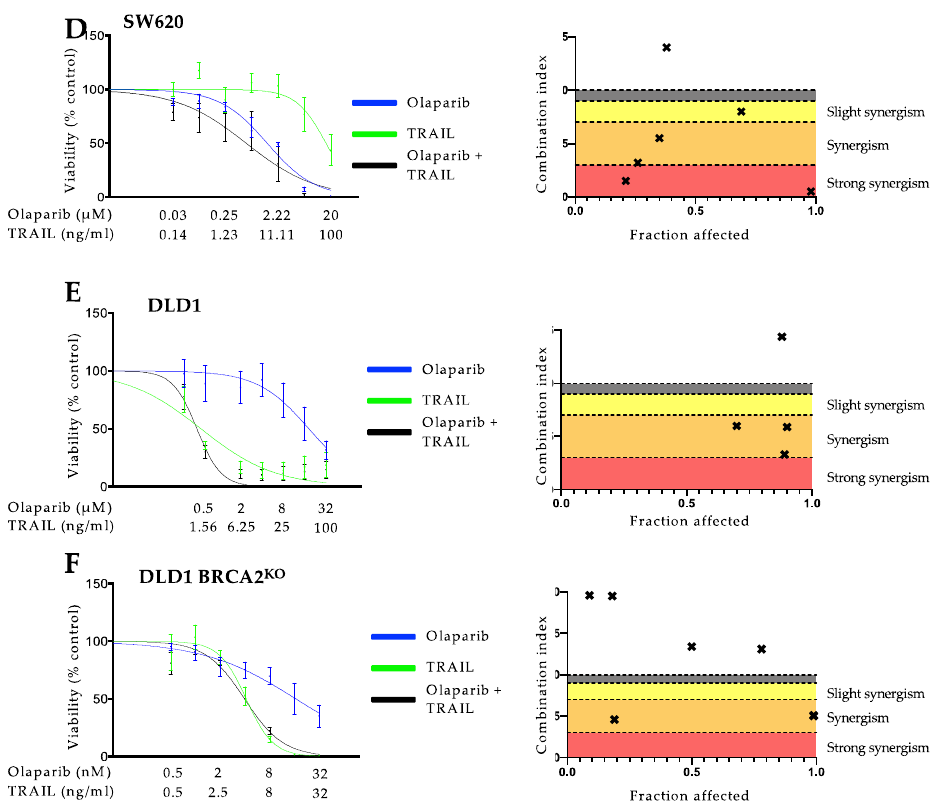
Figure 2. Olaparib and TRAIL synergize in cancer cells independently of BRCA2 status. A-B Proliferation assays of the effects of olaparib, TRAIL, or their combination on BRCA2 deficient CAPAN1 ( A ), and the respective syngenic BRCA2/CIN cell line ( B ) complemented to express wild- type BRCA2. C-D Proliferation assays of the effects of olaparib, TRAIL or their combination on BRCA2 deficient HCT116 ( C ), and BRCA2 proficient SW620 ( D ). E-F Proliferation assays of the effects of olaparib, TRAIL or their combination on wild-type DLD1 cells ( E ) vs. the homozygous BRCA2 knockout colorectal cancer cell line DLD1 termed DLD1 BRCA2 KO ( F ). Cells were treated for 6 days with the indicated agents and subsequently analyzed via SYBR green proliferation assay. All experiments were performed in triplicate with error bars representing SEM from three independent experiments. Drug interactions were analyzed using the Chou–Talalay method with a combination index (CI) of <1, 1, and >1 indicating synergistic, additive, and antagonistic drug effects, respectively. In the combination index graphs, dots depict the CI at the respective fraction of cancer cells affected (x-axis, 0.0 = no cells dead, 1.0 = all cells